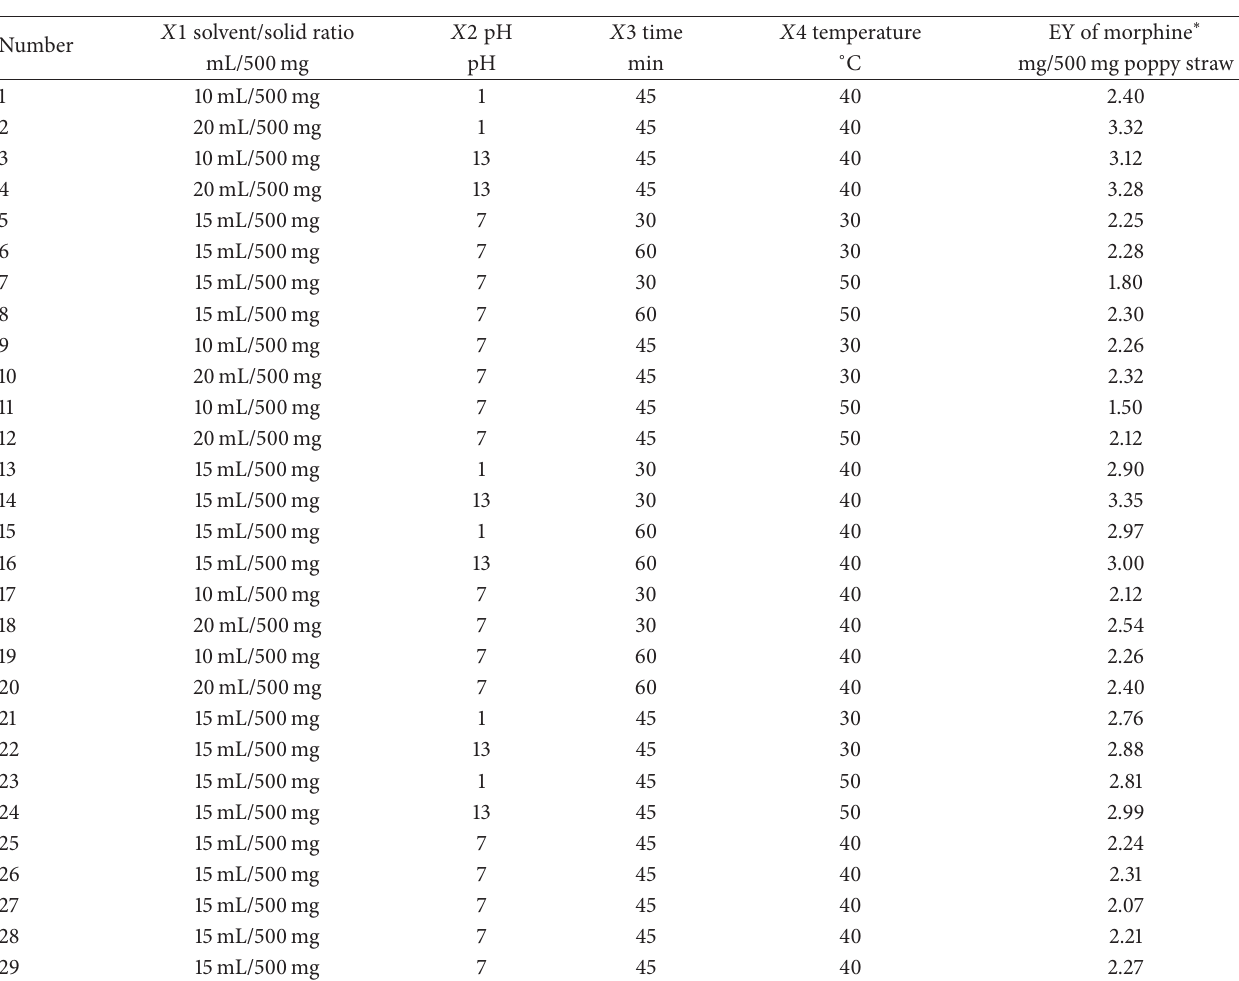
Extraction time Extraction temp.